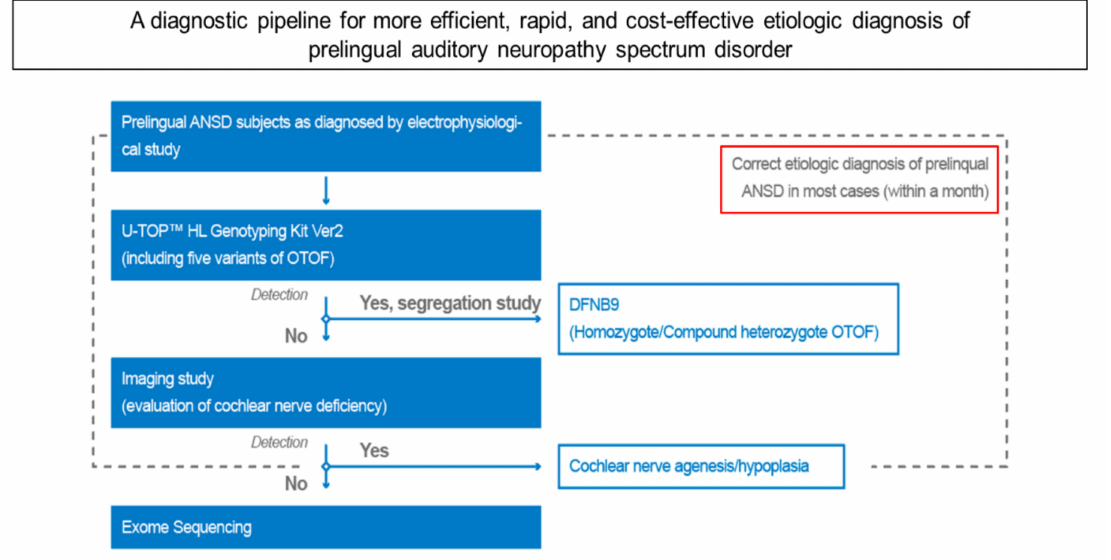
Figure S1, Table S1: Mutational spectrum of prelingual auditory neuropathy spectrum disorder (ANSD) from Korean and East Asian reports, Table